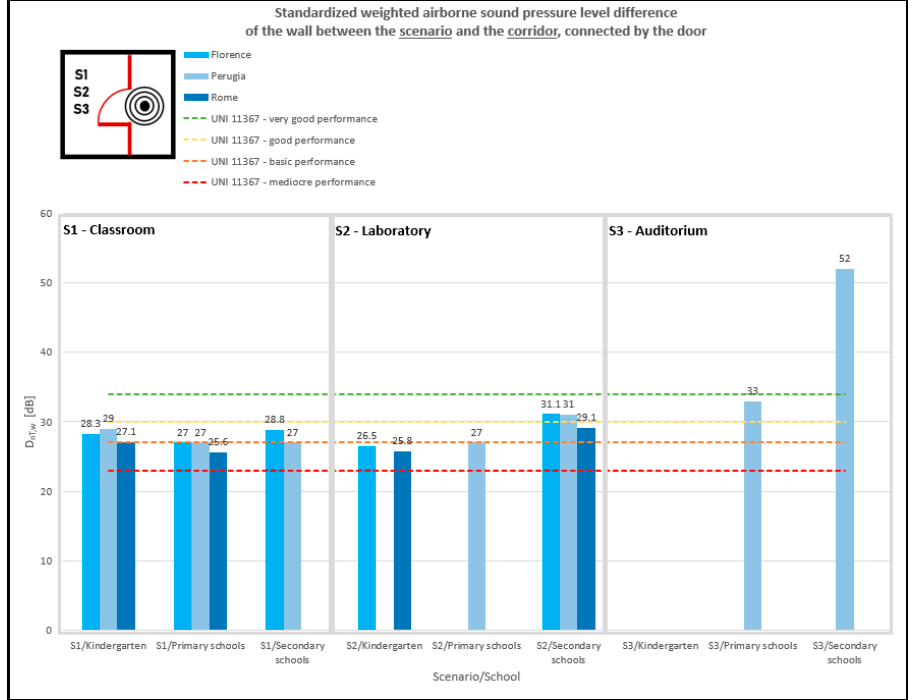
Figure 6. Standardised weighted airborne sound pressure level difference (D nT,w ) of the wall between